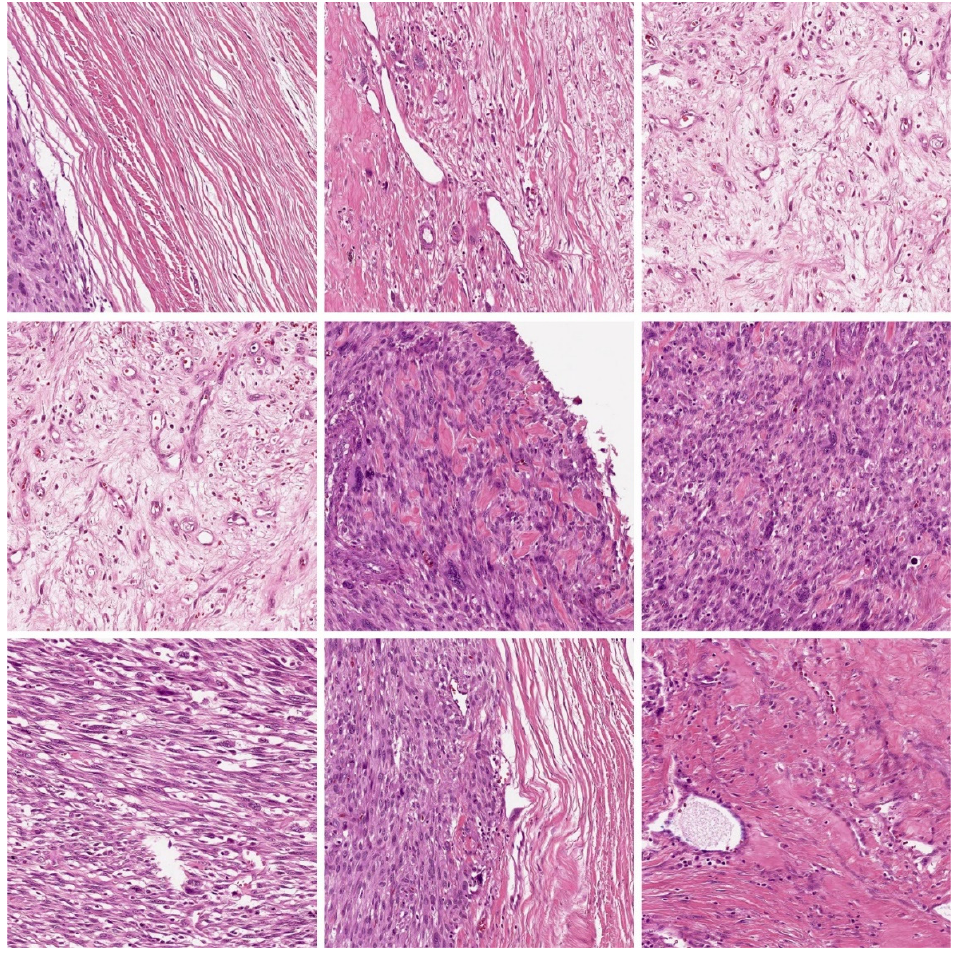
Figure 3. Sample Images.